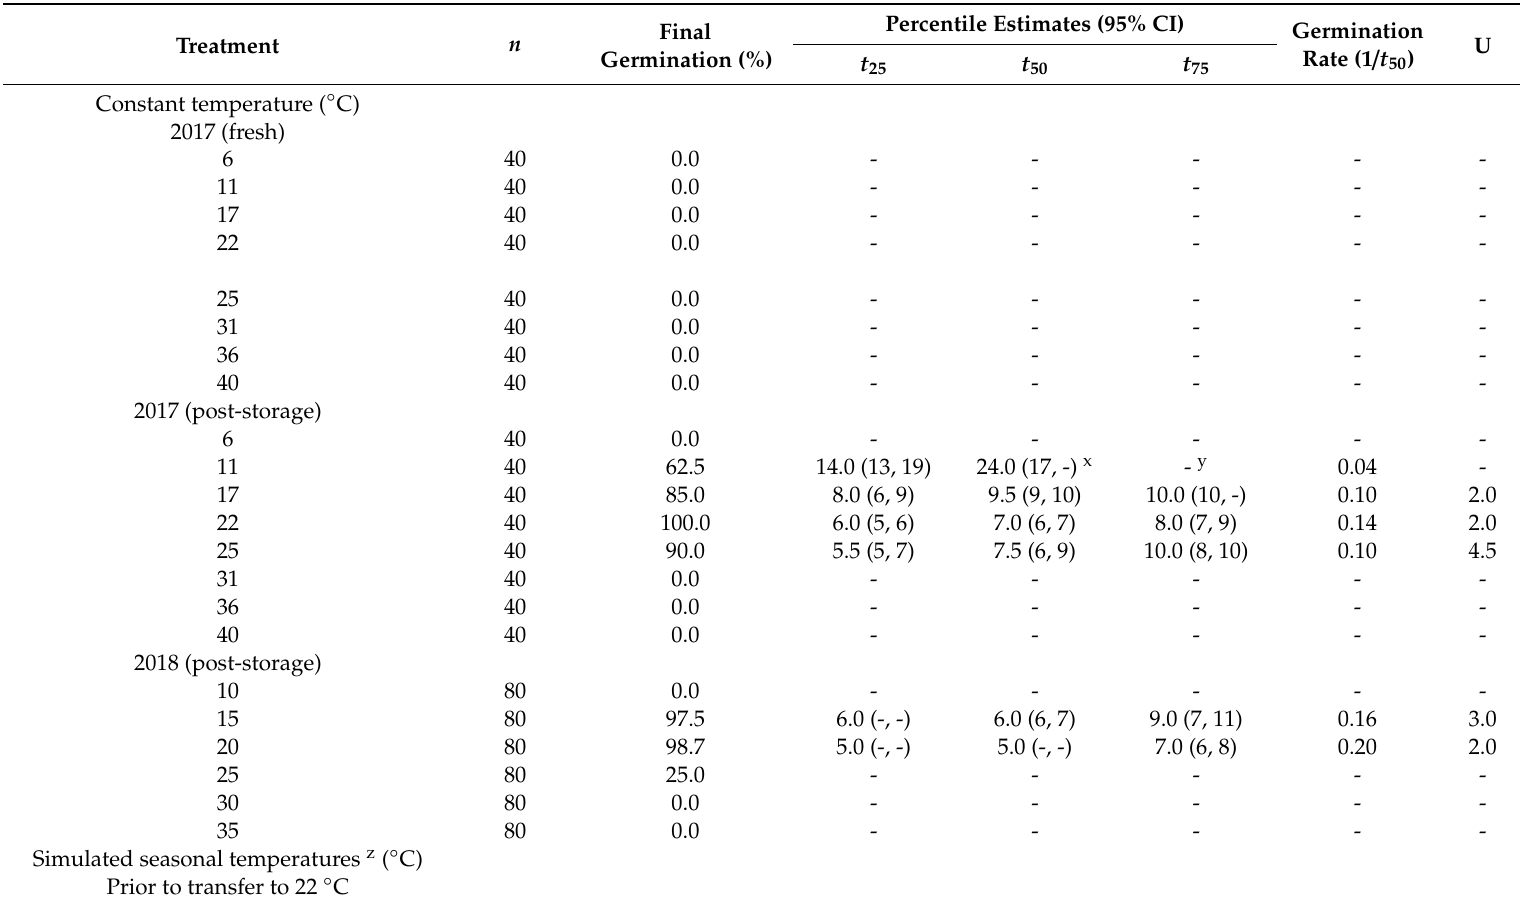
Table 1. The total number ( n ) of Linum arenicola seeds exposed to various experimental treatments and pertinent germination descriptors. Alternating temperatures simulate the average daily maxima and minima for the winter (22 / 11 ◦ C), early spring or late autumn (27 / 15 ◦ C), early autumn or late spring (29 / 19 ◦ C), or summer (33 / 24 ◦ C) throughout Florida. Salinity measurements are in parts per thousand (ppth) NaCl. Kaplan–Meier survival estimates were used to determine the time in days to reach 25, 50, or 75% germination. Germination rate was calculated as 1 / t 50 . Germination uniformity (U) was calculated as U = t 75 − t 25 . CI, confidence